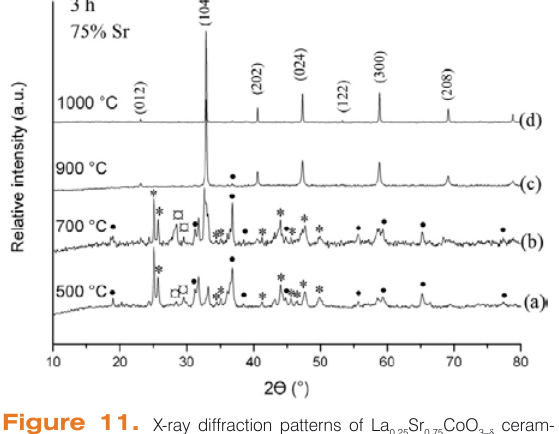
Sr CoO ceram- 0.25 0.75 3– d phase are marked. Im- 3 O , * - SrCO . X-ray diffraction results are very similar. The formation 3 4 3